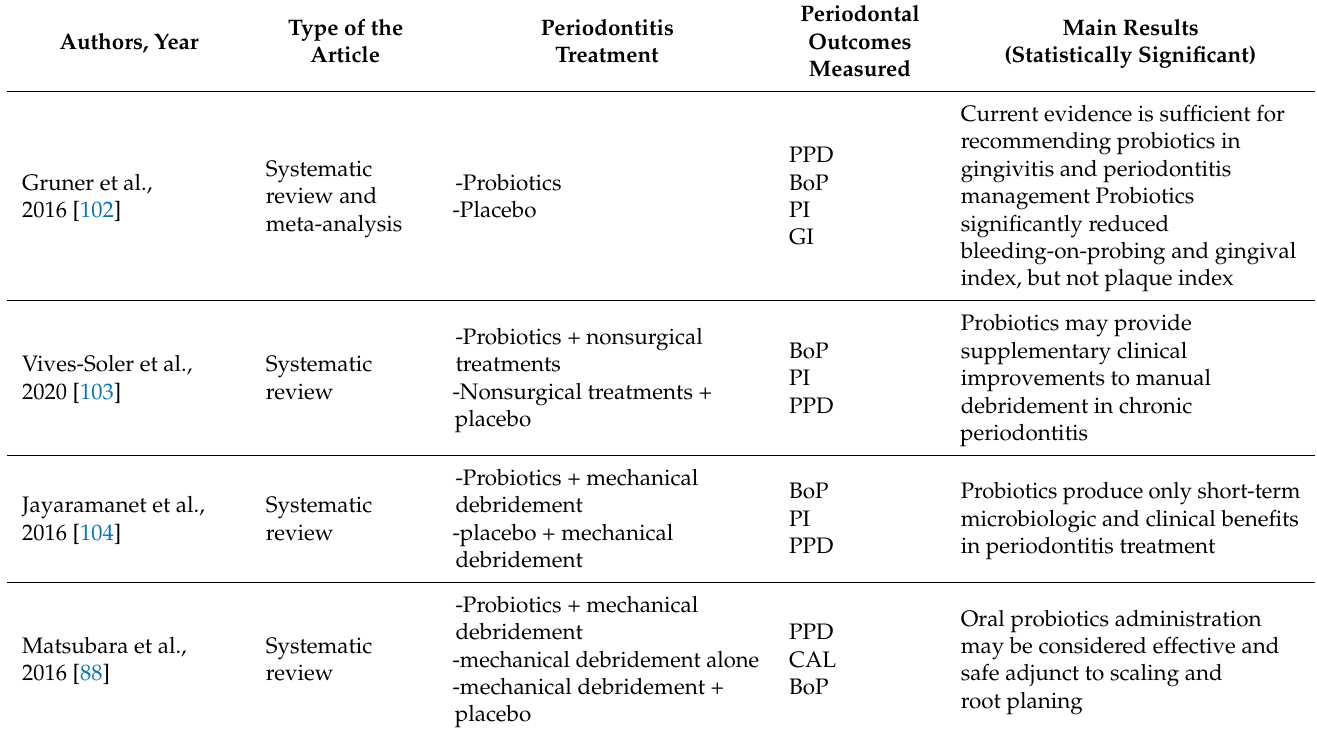
Table 1. Probiotics in periodontitis